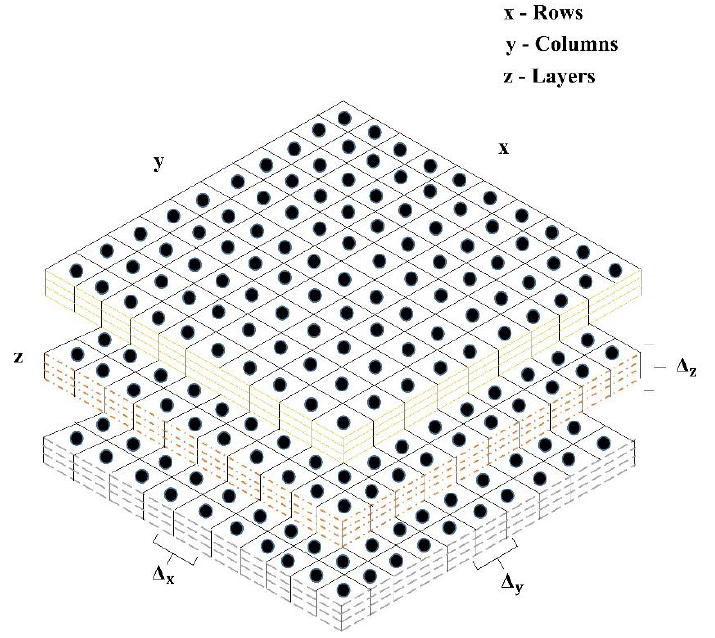
Figure 6. Example of a 3D grid for the geostatistical estimation of the hydraulic head.